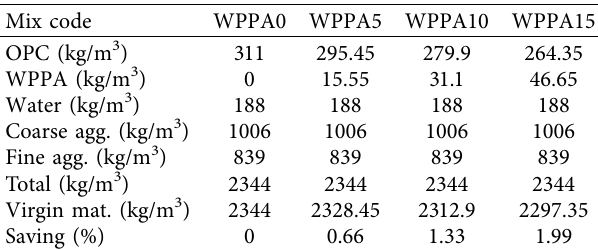
Table 22: Raw material input for one cubic meter of concrete. Mix